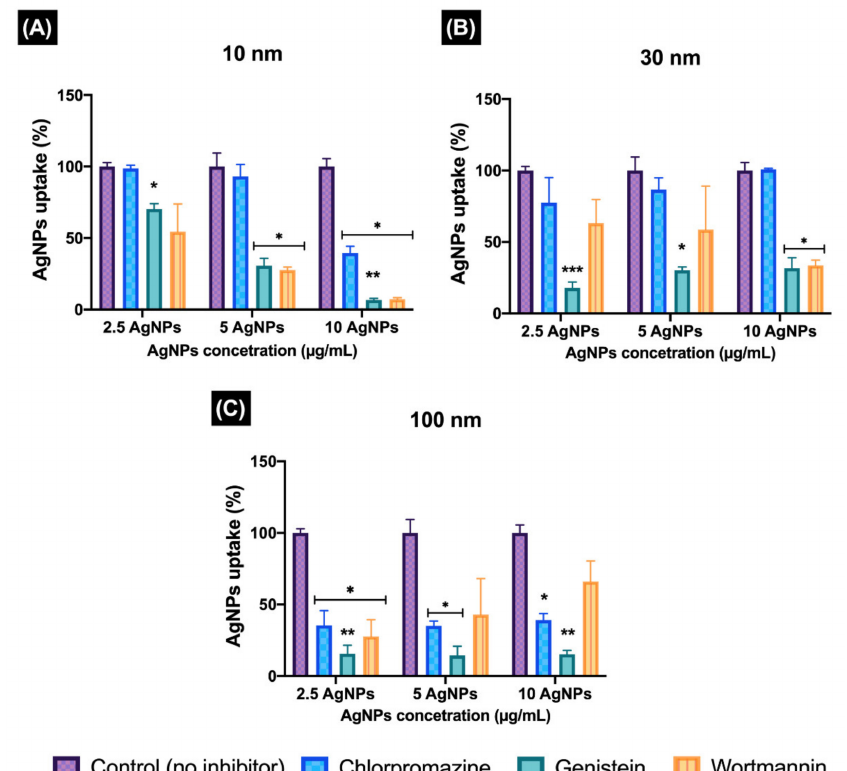
Figure 5. Quantification of the inhibition of the cellular uptake pathways determined as % AgNPs internalised. ZF4 cells were treated with either ( A ) 100 µ g/mL of genistein for 20 min, ( B ) 10 µ g/mL of chlorpromazine for 30 min, or ( C ) 10 µ g/mL of wortmannin for 10 min. After treatment with the chemical inhibitor, cells were treated with 2.5, 5, and 10 µ g/mL of different AgNP sizes (10, 30, and 100 nm) for 2 h. ICP–MS results for total Ag were normalised to percentage (%) against their untreated control (no inhibitor) for each AgNP concentration and size. Results represent the mean of three individual replicates and their standard deviation. Data with asterisks (*) indicate a statistically significant difference of the inhibitor treatments (* p < 0.05, ** p < 0.01, and *** p < 0.001) compared to the naive cells (non-inhibition) at each time point. All bars under the brackets are included within the asterisk